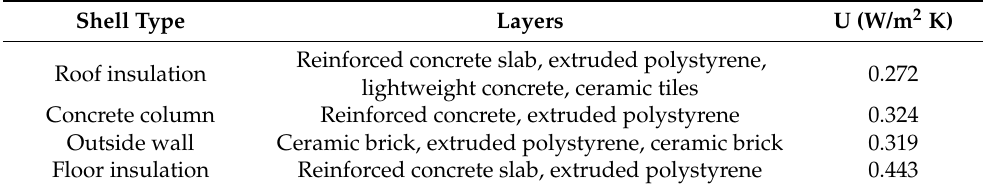
Table A1. Building insulation data (U-values).